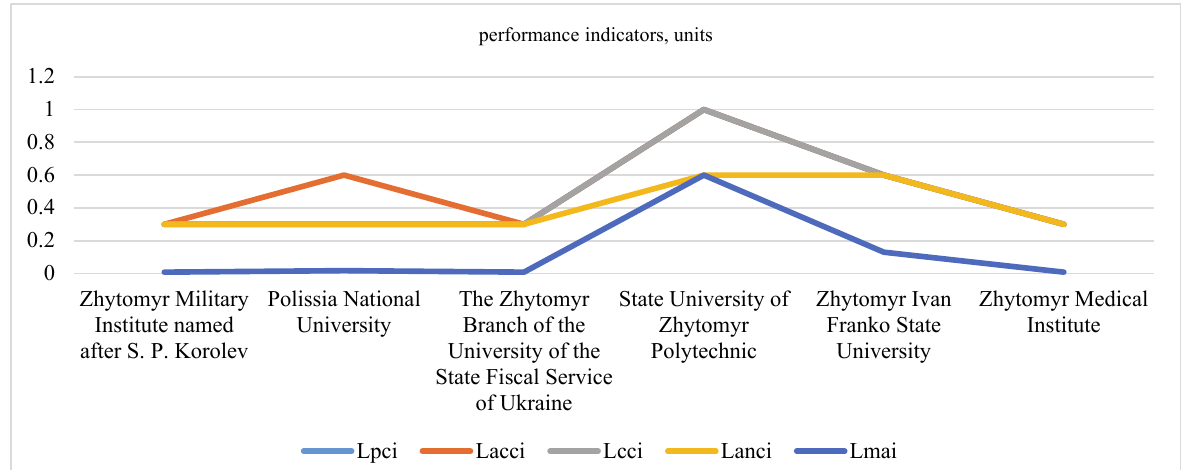
Fig. 2. The level of management accounting introduction in the activities of SIHE in